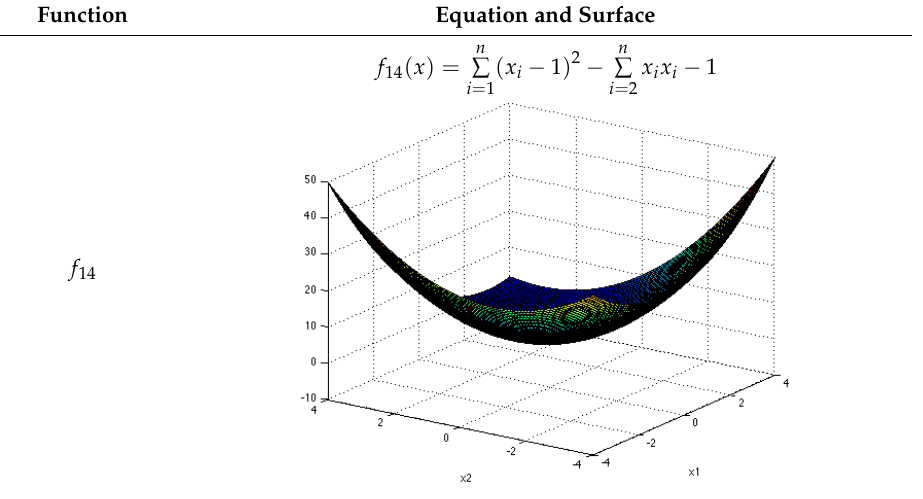
Table 6. Benchmark functions utilized for the experiments (optima different from zero).